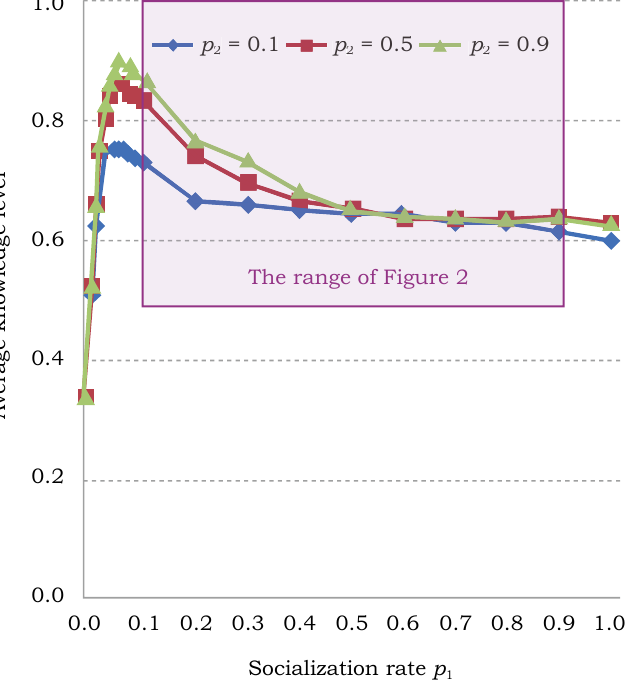
organizational code to improve” (March, 1991, p. 76) cannot be